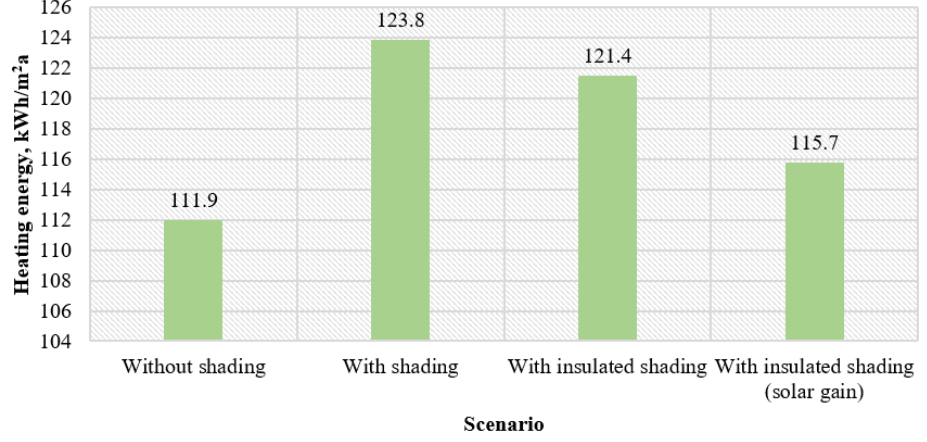
Fig. 5. Annual energy demand for space heating at 4 scenarios with natural